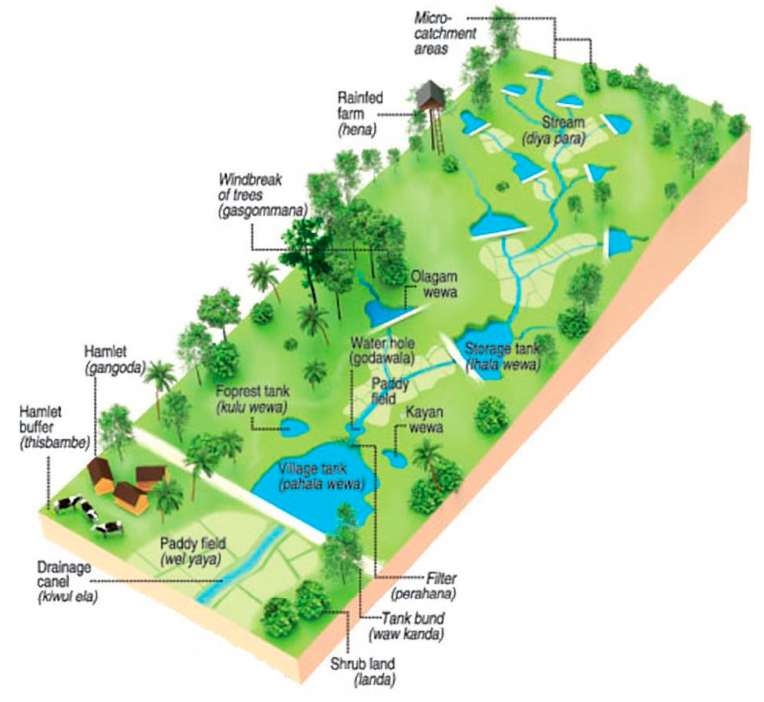
Figure 2. A drawing of a tank cascade system [31].